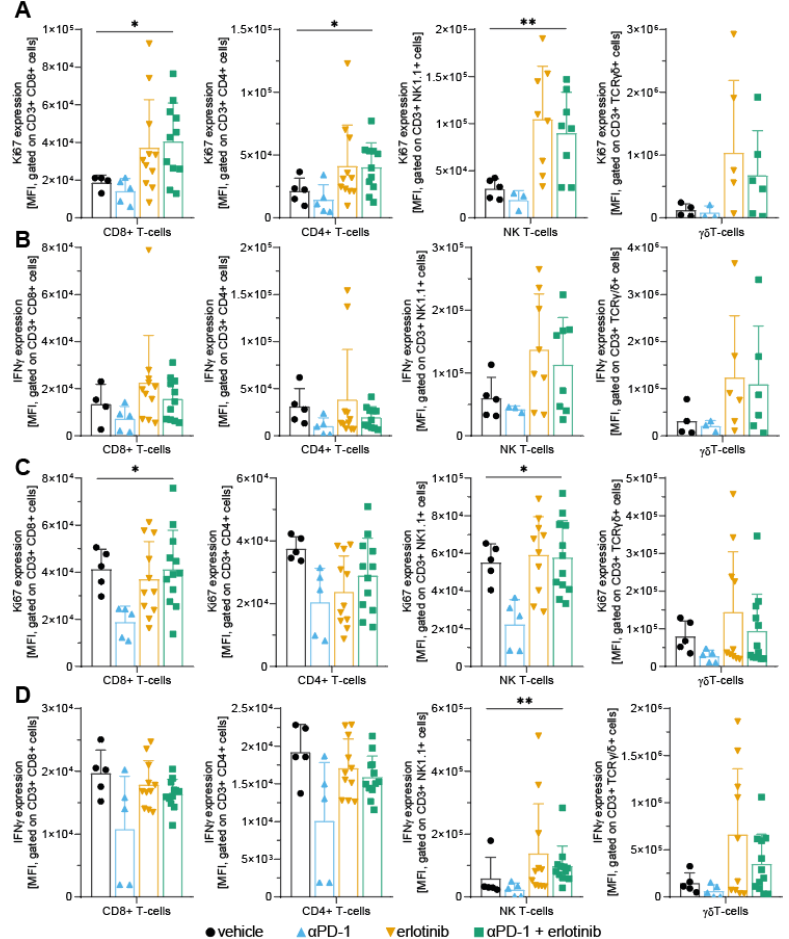
Figure 2. EGFR inhibition enhances proliferation and activation of T-cells in TME. ( A , B ) Mean fluorescence intensity data of ( A ) intracellular Ki67 and ( B ) intracellular IFN γ expression, illustrating proliferation and activation status, respectively. Data shown for cytotoxic CD8 + T-cells, helper CD4 + T-cells, NK T-cells, and γδT -cells from lung tumour tissue. ( C , D ) Mean fluorescence intensity data of ( C ) intracellular Ki67 and ( D ) intracellular IFNγ expression, illustrating proliferation and activation status, respectively. Data shown for cytotoxic CD8 + T-cells, helper CD4 + T-cells, NK T-cells, and γδT -cells from spleen tissue ( n = 5 – 12 mice per group). ( A – D ) Data are shown as the mean with SD; the statistical test used was the Kruskal – Wallis test to compare all therapy groups (statistically significant changes are indicated across all groups as follows: * p < 0.05; ** p < 0.01).